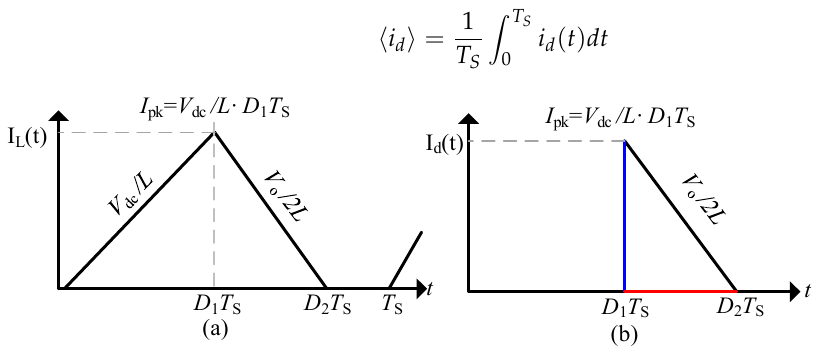
Figure 5. DCM operation ( a ) inductor current and ( b ) diode current.